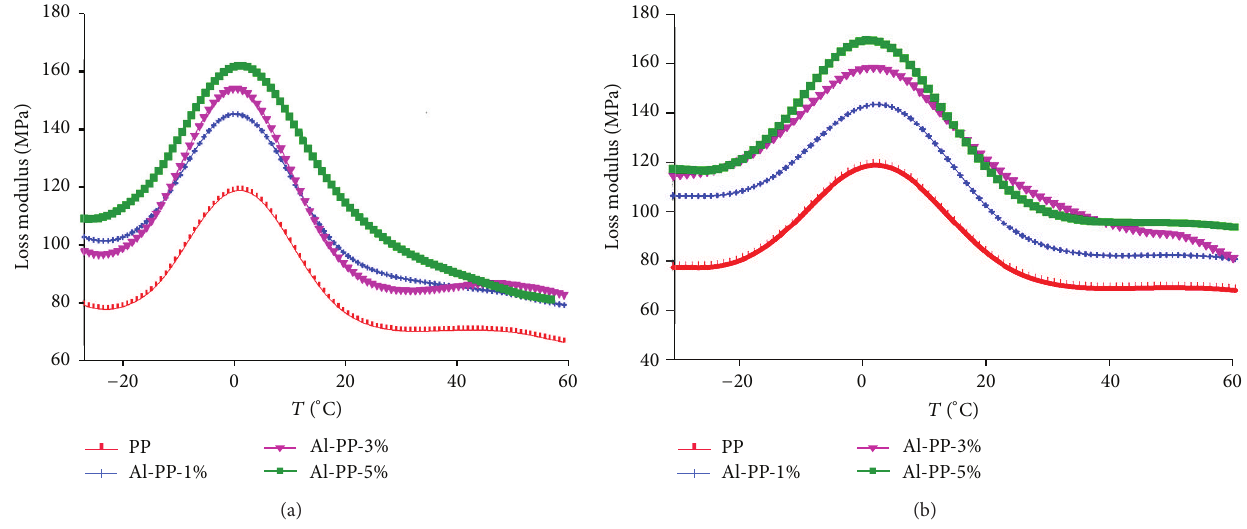
Figure 5: Loss modulus of unfilled PP and PP/nano 𝛼 -Al 2 O 3 composites with different filler loading (a) in the absence of dispersant and (b) in the presence of dispersant.